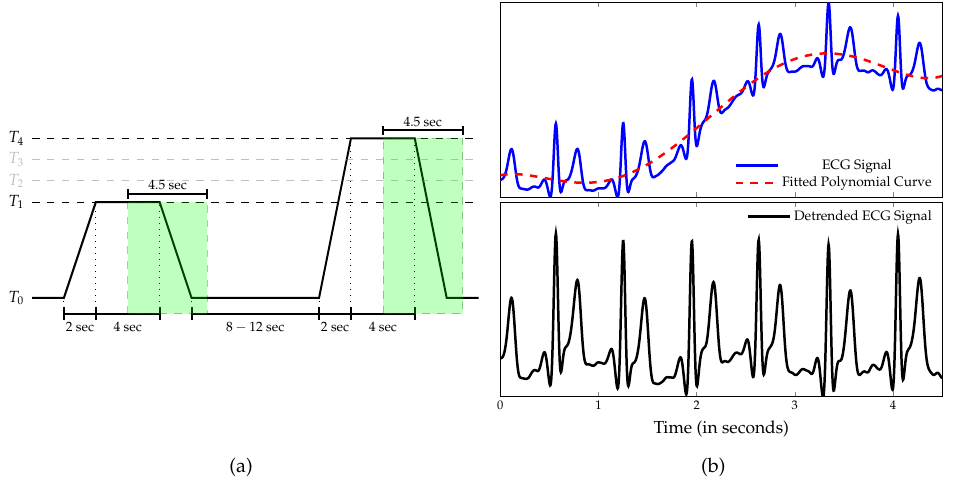
Figure 2. Data preprocessing. ( a ) Signal Segmentation. The classification experiments were performed on windows of length 4.5 s with a temporal shift of 4 s from the elicitations’ onset. ( b ) The ECG signal was further detrended by subtracting a least-squares polynomial fit from the preprocessed signal.